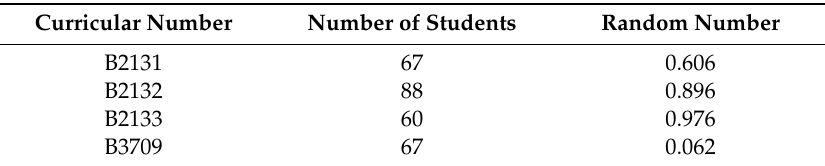
Table 1. Results of the single-attribute complete randomization.